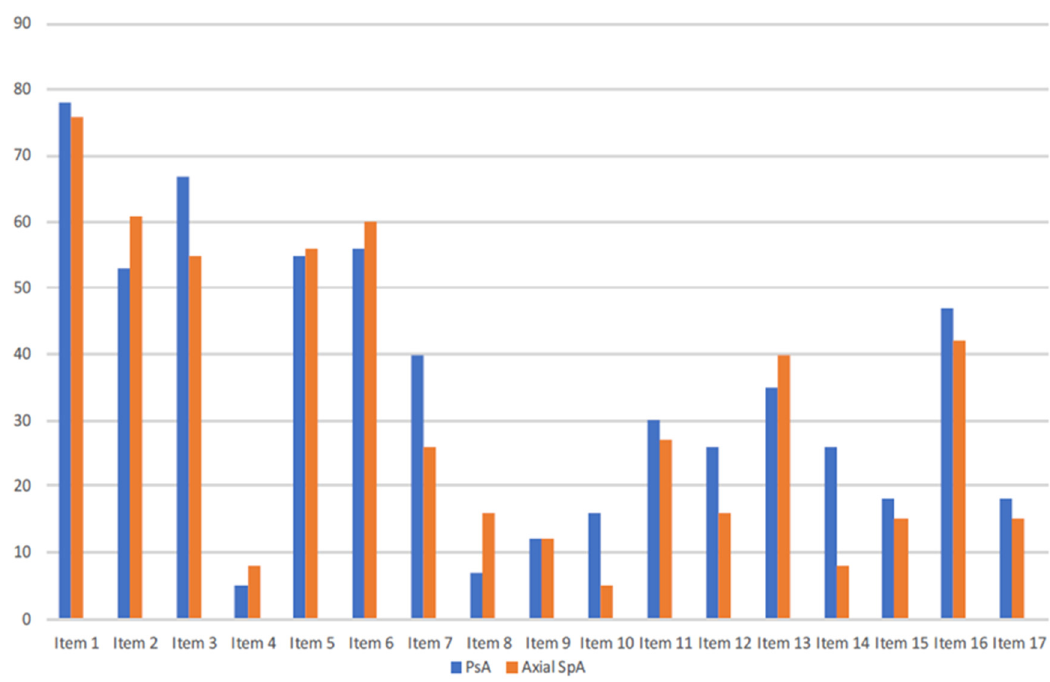
Figure 1. The distribution of the different components of the ASAS HI between both SpA